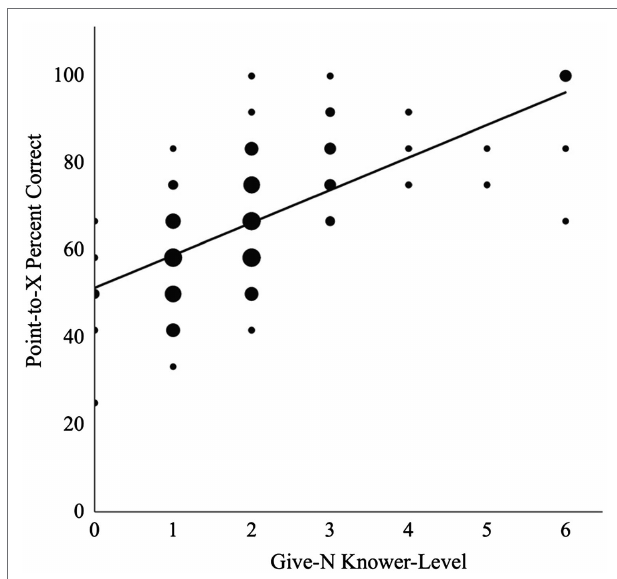
FIGURE 1 | Children’s performance in the Point-to-X task and the Give-N